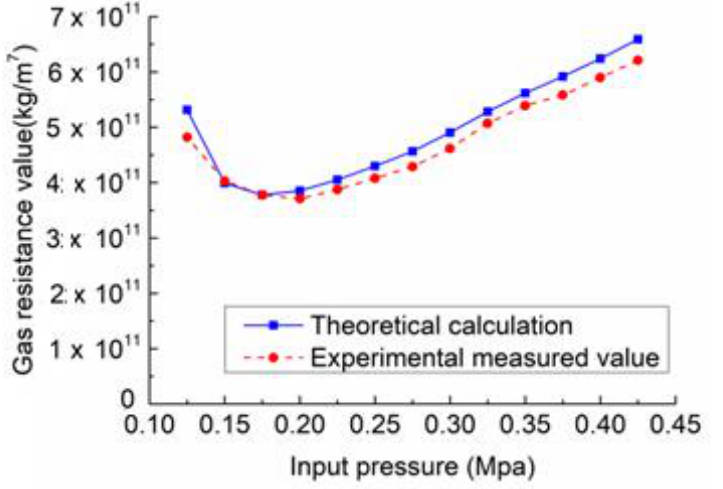
Figure 7. Comparison curve between the theoretical and experimental values of the gas resistance and input pressure of the tube with an inner diameter of 2 mm and length of 1.0 m.